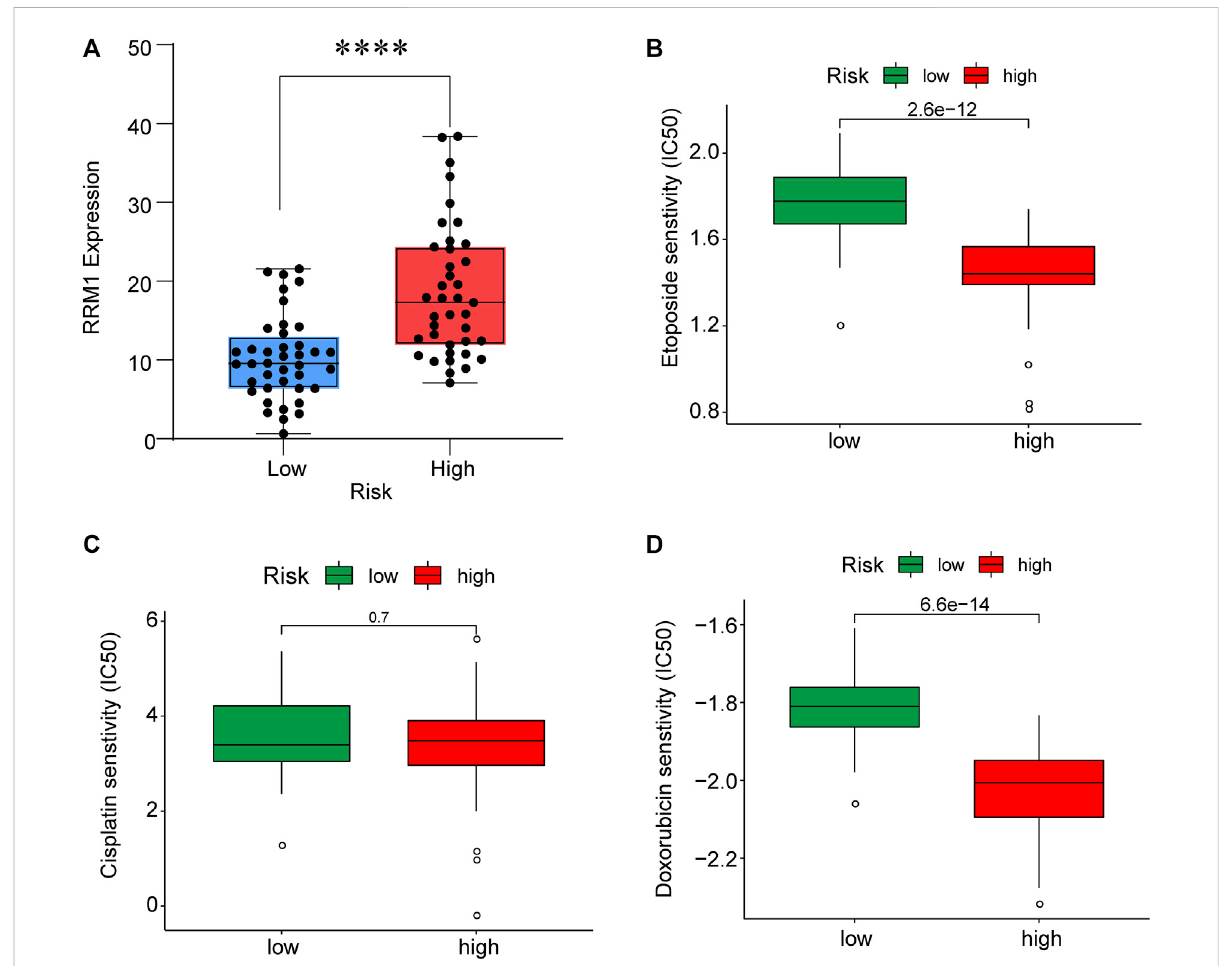
FIGURE 9 RRM1 expression in low- and high-risk groups (A) . Etoposide, cisplatin and doxorubicin senstivity in low- and high-risk groups (B – D)